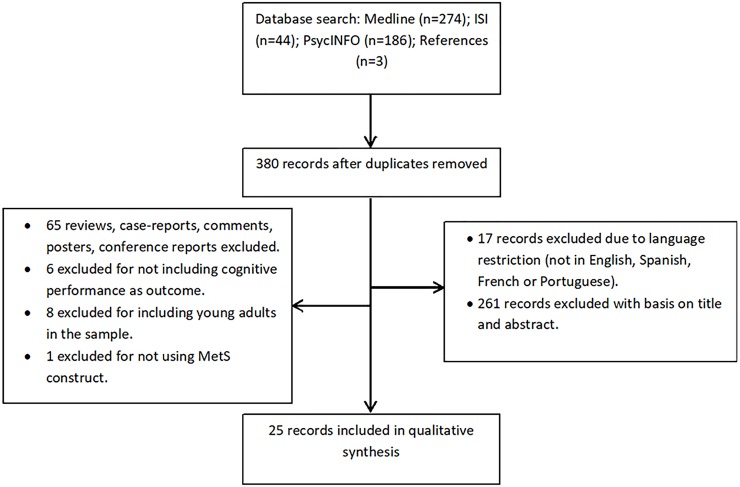
Stages of data search and selection.